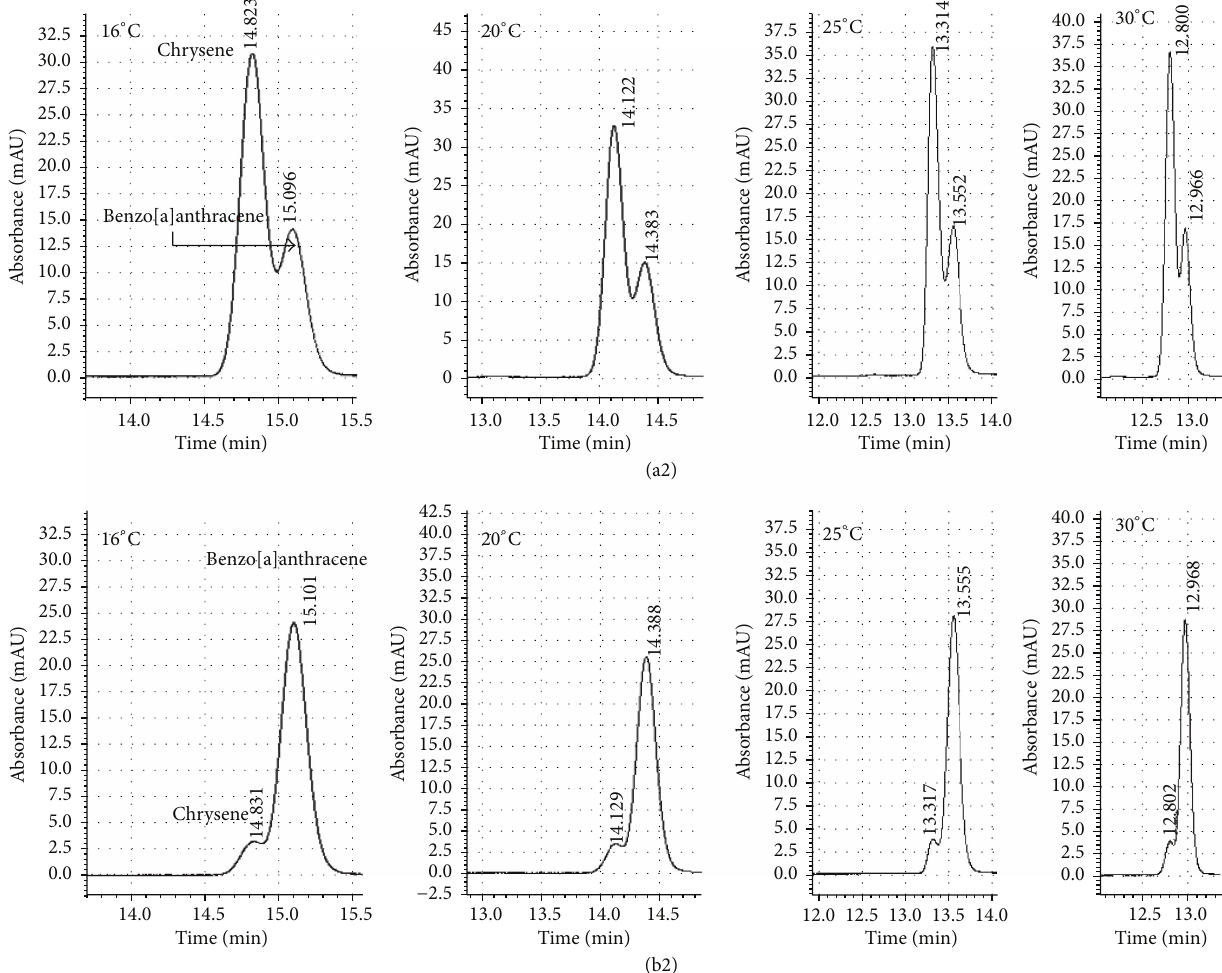
Figure 7: Influence of column temperature on the separation of chrysene and benzo[a]anthracene using the Kinetex LC-PAH column; (a2) at 266 nm; (b2) at 286 nm.